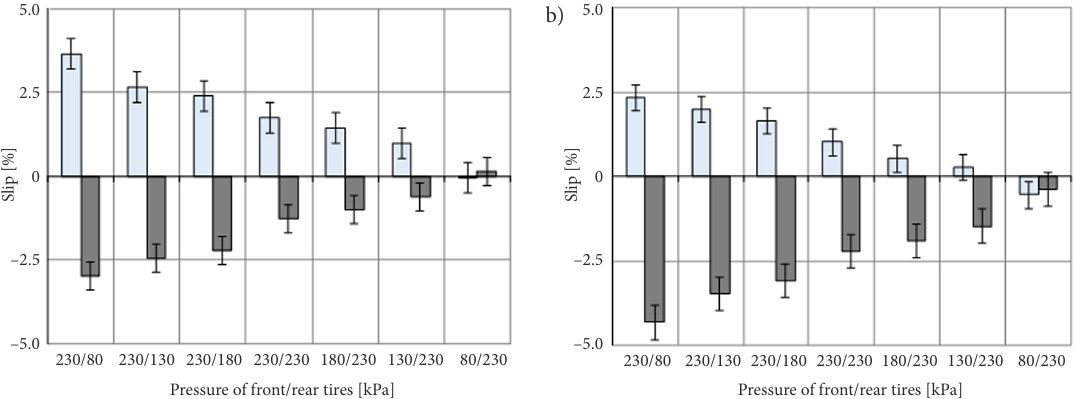
[kPa]230/80 Pressure of front/rear tires Figure 2. Front and rear wheels’ slip for the pulled tractor travel mode that included 4WD and 1.39 m/s speed for different front and rear tire pressures: a - when the tractor was pulled with the gear switched off; b - when the tractor was pulled with the gear enabled but the fuel feed was cut off; light-toned columns – the front wheels; dark-toned columns – the rear wheels